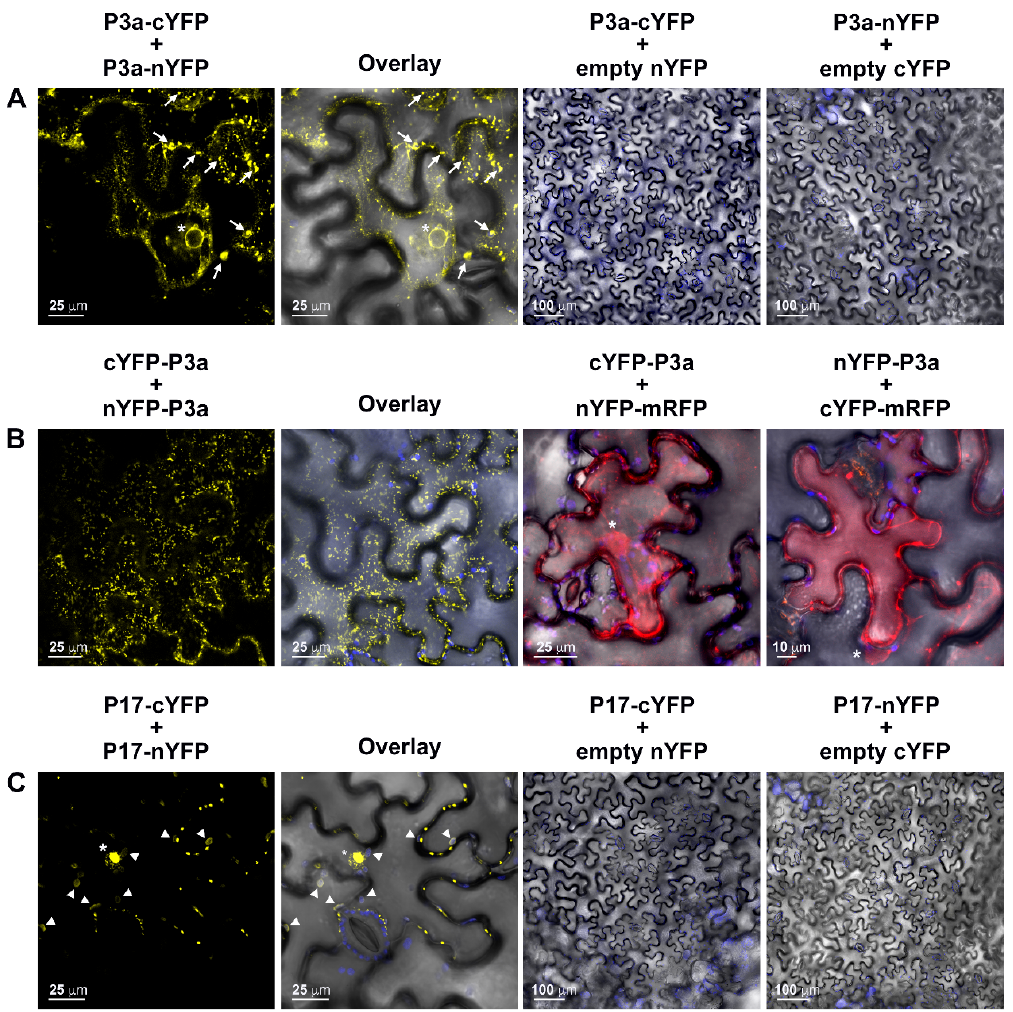
Figure 3. In planta self-interaction assays of PLRV P3a shows that tag orientation influences subcellular localization of the P3a homodimer. Panels represent single-plane confocal micrographs of N. benthamiana leaf epidermal cells co-expressing bimolecular fluorescence complementation (BiFC) fragments (nYFP and cYFP) fused to the ( A ) C-terminus; ( B ) the N-terminus of P3a; or ( C ) the C-terminus of the PLRV P17 movement protein. The fluorescence signal from the reconstitution of YFP due to self-interaction of the viral proteins is false-colored yellow. Negative controls are represented in the right two micrographs with ( A ) co-expression of the P3a N-terminal BiFC fusions with monomeric red fluorescent protein (mRFP, red fluorescence) fused to the complementary tag and ( B , C ) co-expression of the viral C-terminal BiFC fusion proteins with their complimentary empty vector tag. The overlay of the bright field images are shown in the column marked “Overlay” and in negative control images with chloroplast autofluorescence falsely colored blue. Fluorescent protein detection in the nuclei (white asterisks), aggregates (white arrows), and chloroplasts (white arrow heads) are highlighted. Scale bars represent the length indicated in micrometers ( μ m).